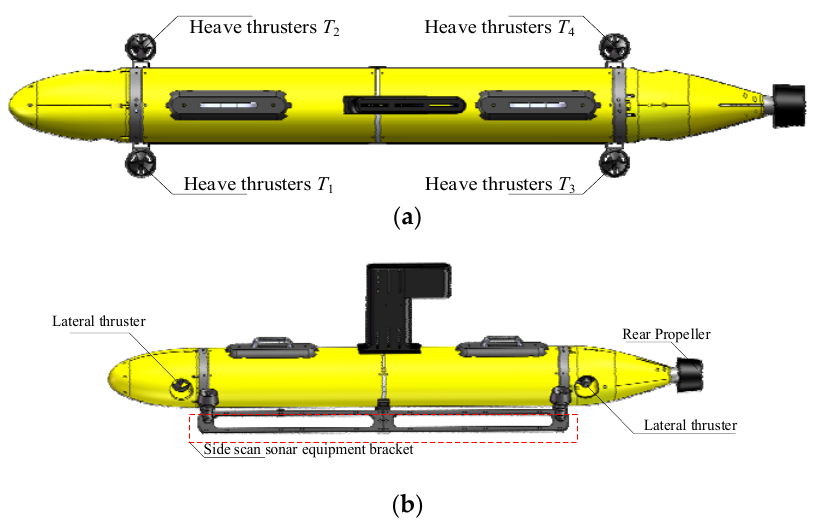
Figure 2. AUV mechanical structure: ( a )Vertical view and ( b ) lateral view. The notations in the dynamic model are summarized in Table 1. Table 1. Notations used in this